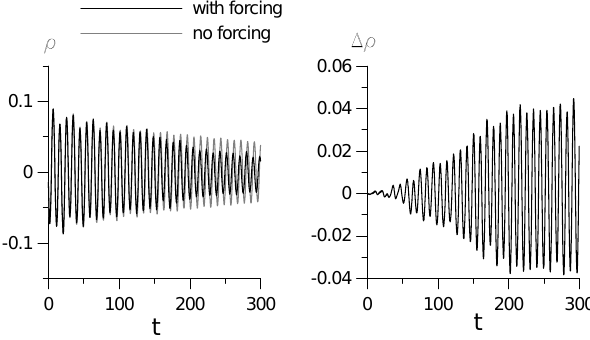
Fig. 5. Temporal development of the density deviation in center of the pycnocline, at a point with coordinates x = 20, y = 0, z = 8, obtained in DNS for IW wavelength λ = 4, with and without turbulence forcing, ρ f and ρ (in black and grey line, left) and the difference ρρ− (right) . Fig. 4b. Vertical profiles of the velocity fluctuation and mean density (in red line) obtained in DNS with turbulence forcing on and off (in black and blue line, respectively) and IW with wavelength λ = 4 at t = 300. The reference (initial) density profile, ρ ref (z) , is shown as a dashed line for comparison.